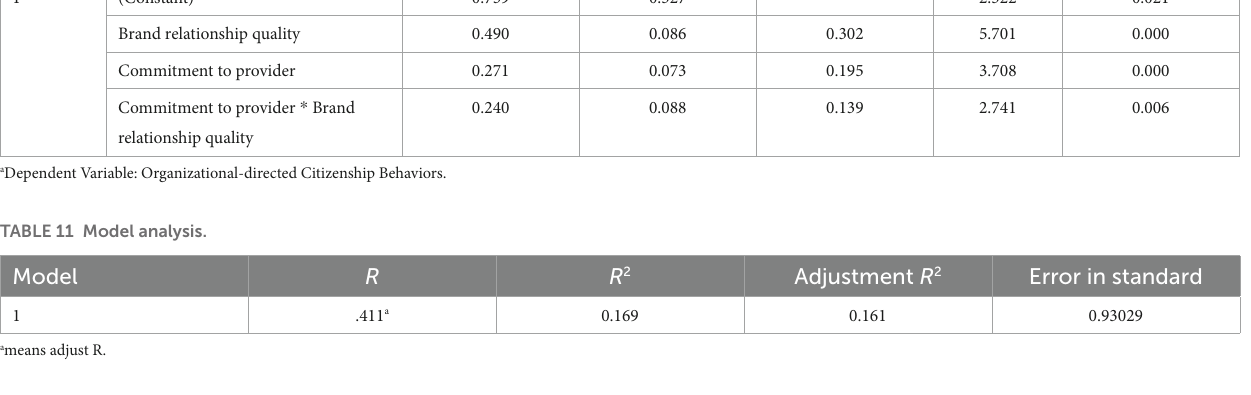
TABLE 12 ANOVA a analysis.